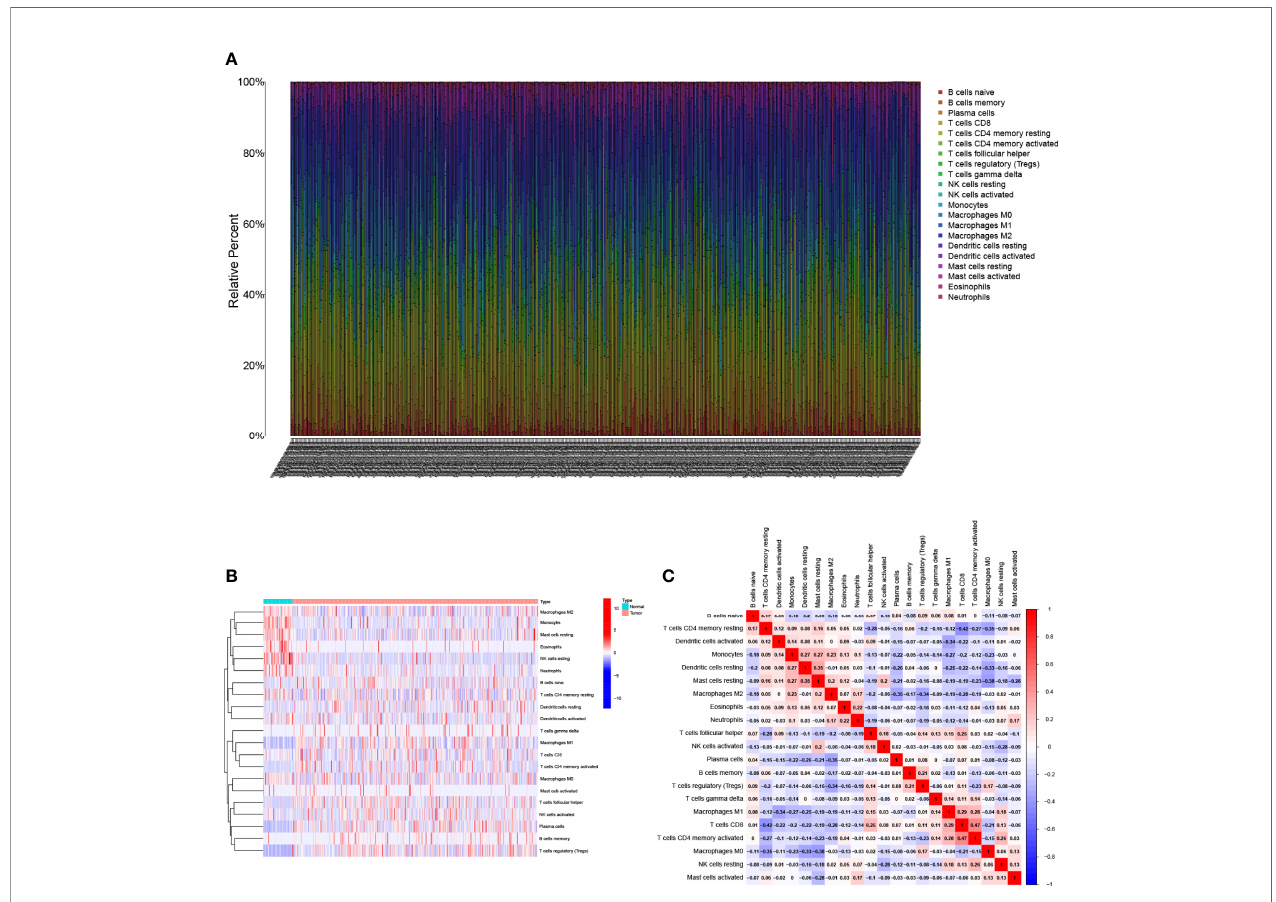
FIGURE 1 | Landscape of immune cell in fi ltration in the tumor immune environment of LUAD. Subpopulation of 22 immune cell subtypes (A) and proportional heatmap of 22 TICs in each LUAD samples (B) . (C) Intrinsic correlation of 22 in fi ltrating immune cells in